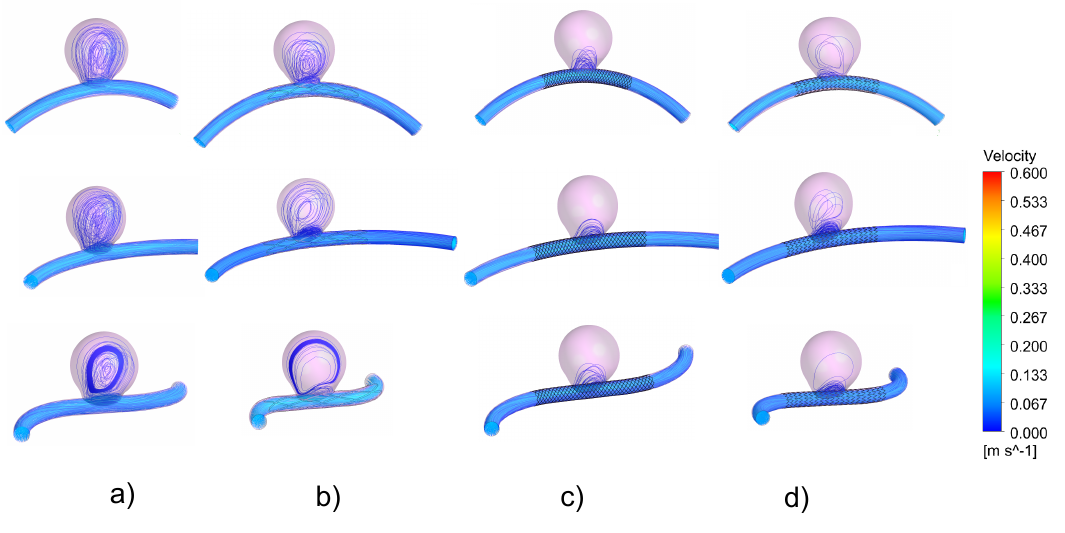
Figure 3. Streamlines introduced at the inlet of each model, colored with the local velocity magnitude, plotted at diastole for the same vascular geometry and for the three flow diverter stents considered in this study: ( a ) no stent, ( b ) STENT 1, ( c ) STENT 2 and ( d ) STENT 3.